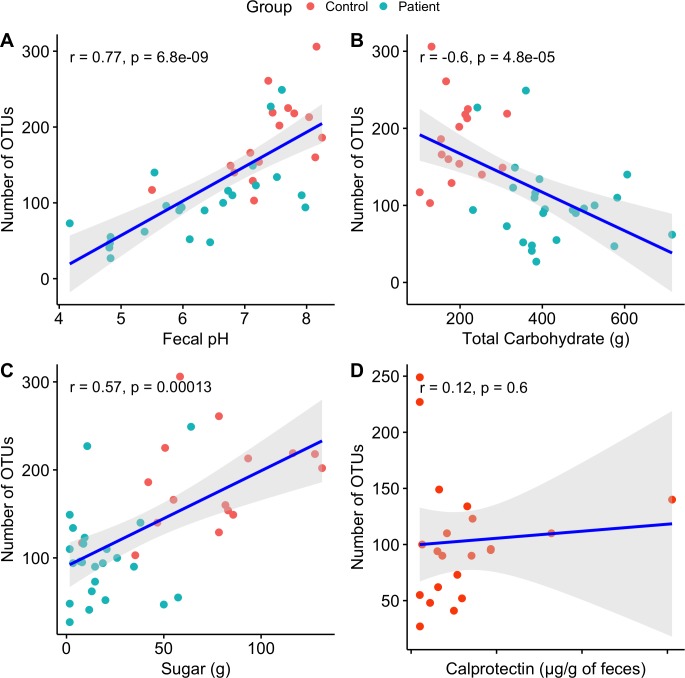
Correlations between the microbiota and diet, faecal pH, and gut inflammation.